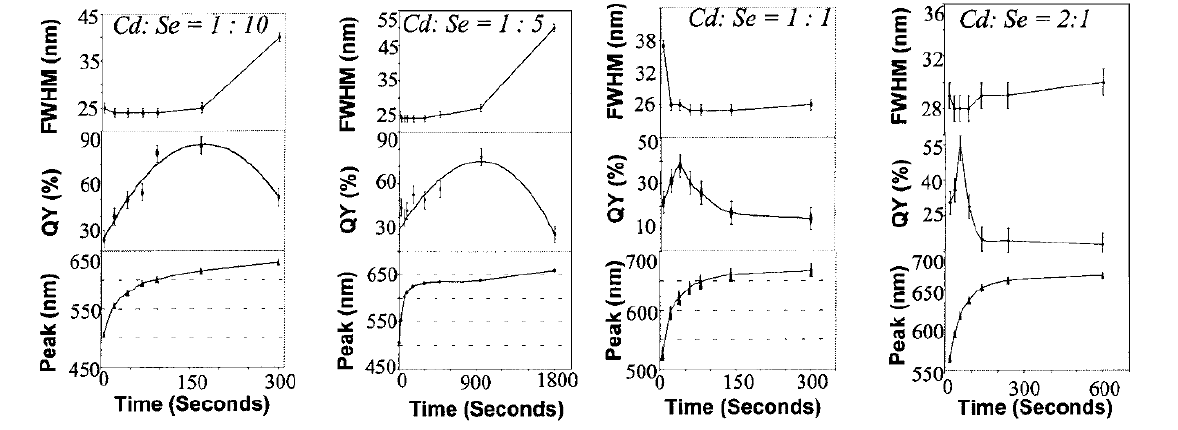
Figure 13. Change of quantum yield with reaction time and growth of particles, and stoichiometric ratio of anion and cation precursors (reprinted with permission from [164]. Copyright 2002 American Chemical